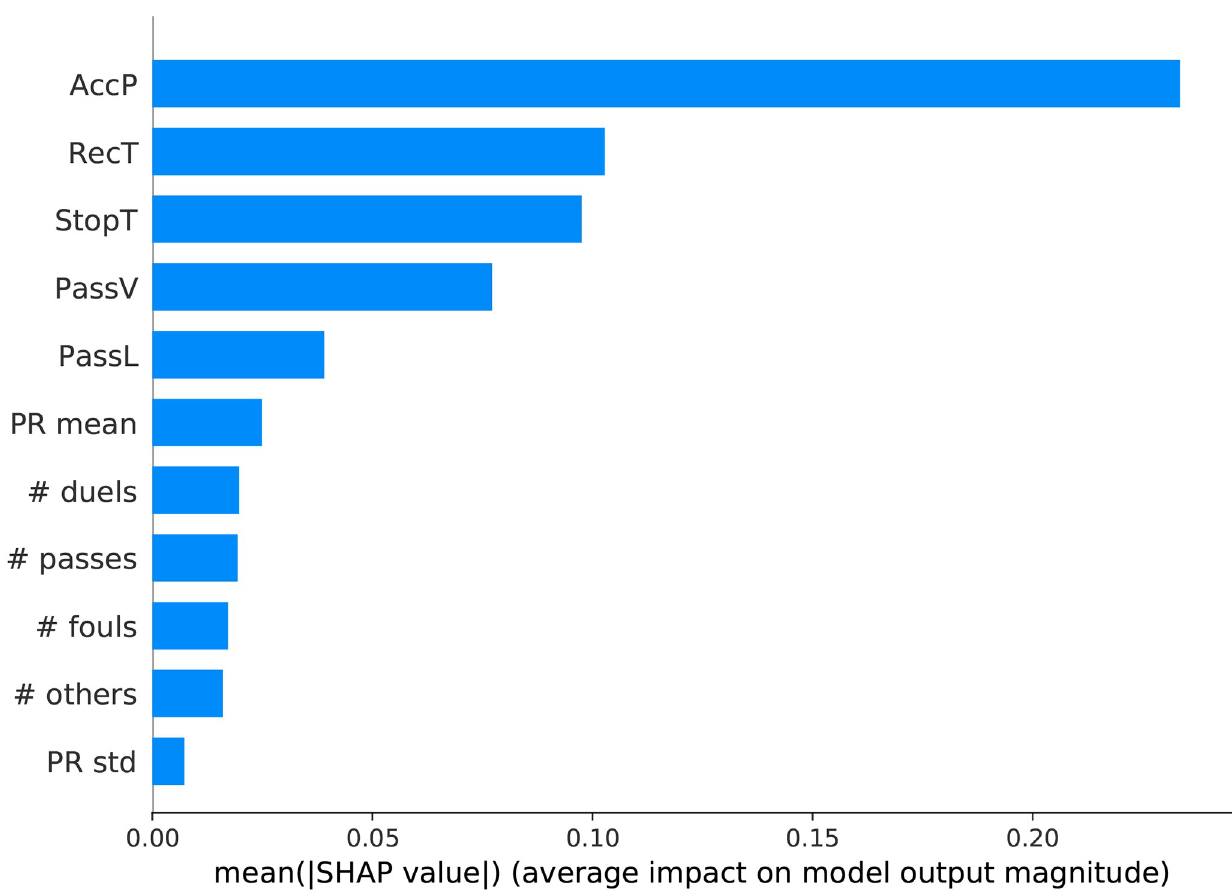
Fig 6. Ranking of features importance (mean Shap value) extracted from the team gender